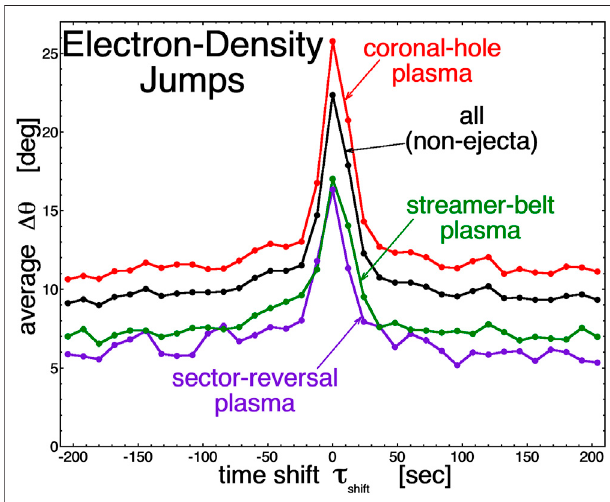
FIGURE 3 | The superposed epoch average value of the 30-s change in the magnetic- fi eld direction is plotted as a function of time from the identi fi ed core-electron density boundaries in the WIND data set at 1 AU.